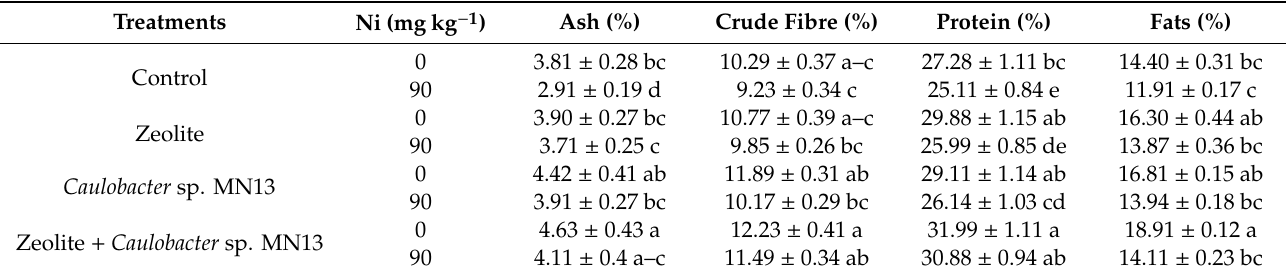
Table 5. E ff ect of Caulobacter sp. MN13 and zeolite on biochemical parameters of sesame in normal and Ni contaminated soils.